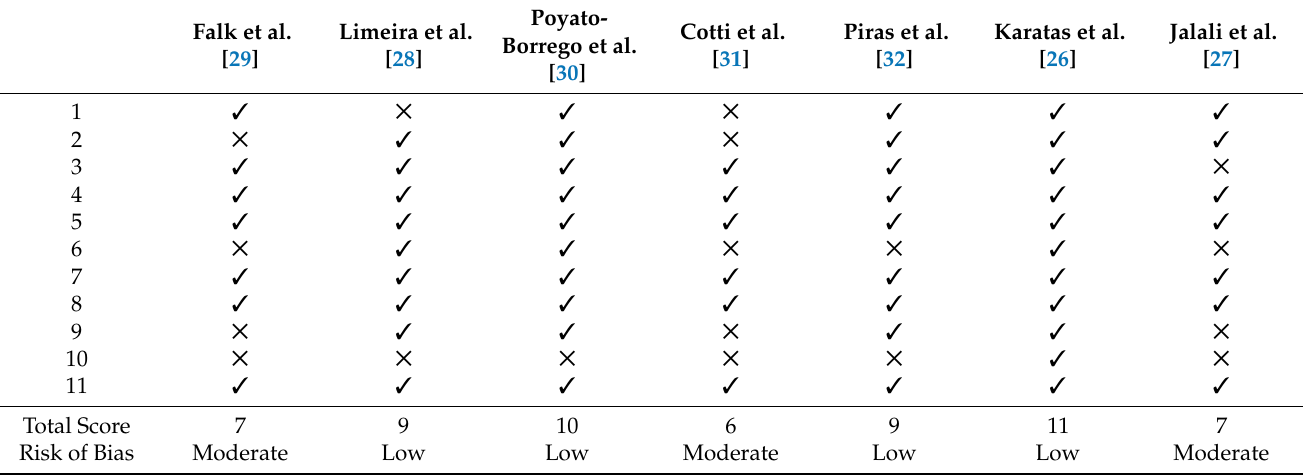
Table 7. Results of quality assessment using an adapted version of the STROBE guidelines. Falk et